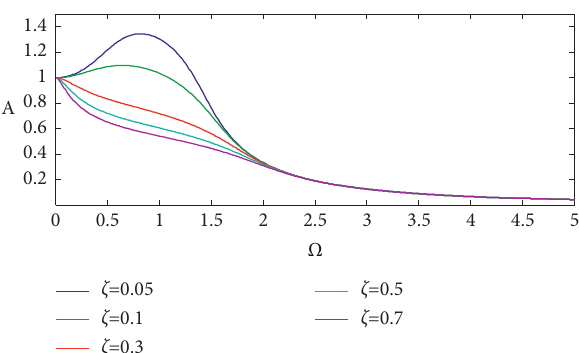
Figure 5: Amplitude-frequency ratio diagram for different relative damping coefficient ζ .